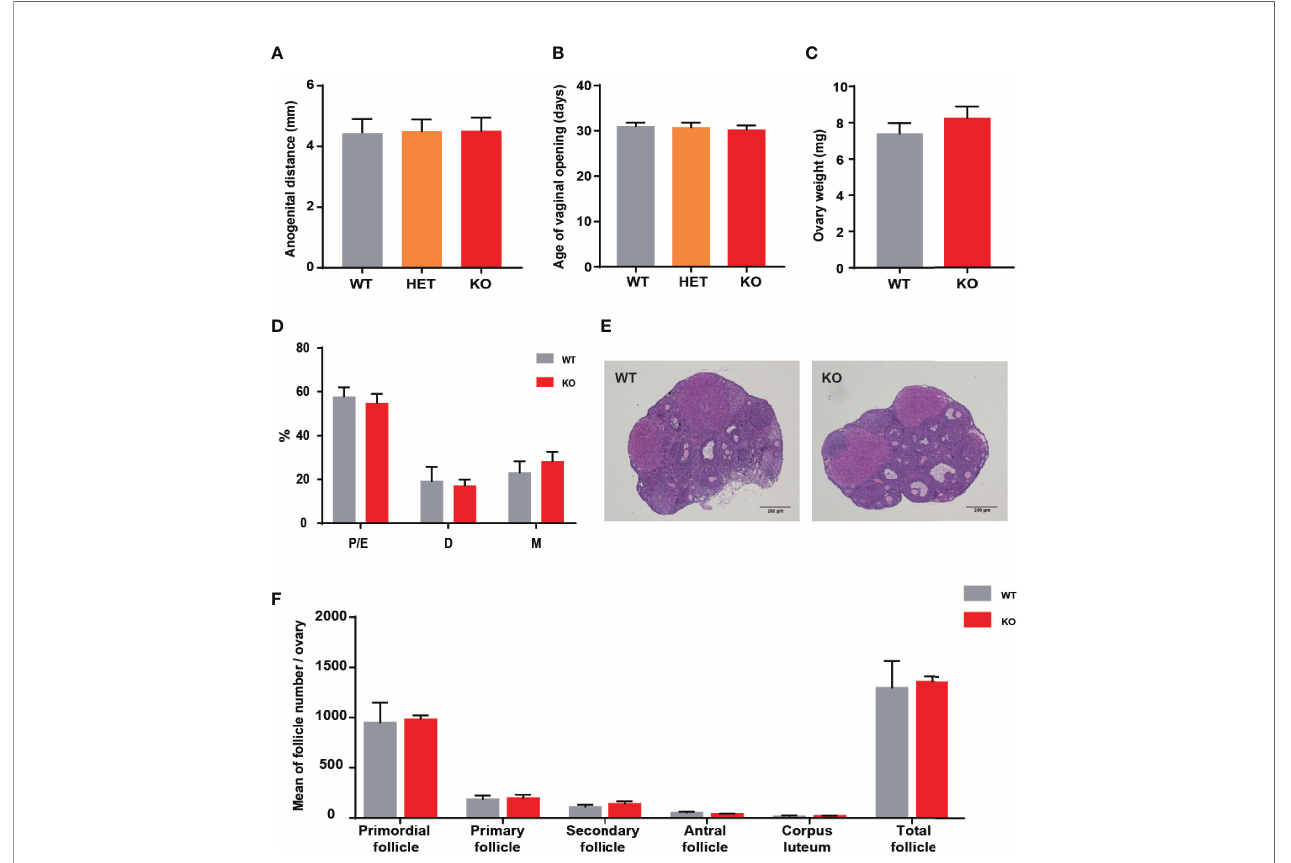
FIGURE 2 | Thada knockout mice did not present ovarian development abnormalities. (A) Anogenital distance (AGD) of 4 week-old mice (n = 4-7). (B) Vaginal opening time was similar between WT and KO mice (n = 4-7). (C) The ovarian weights were no different between WT and KO mice (n=8-10). (D) Estrous cycle pro fi le of WT and KO mice (Proestrus-Estrus P/E), Matestrus M, Diestrus D) (n = 6-9). (E) Hematoxylin-Eosin stained ovaries sections of WT and KO mice, scale bar=200 m m. (F) The numers of these follicles at different developmental stages of maturation(n =